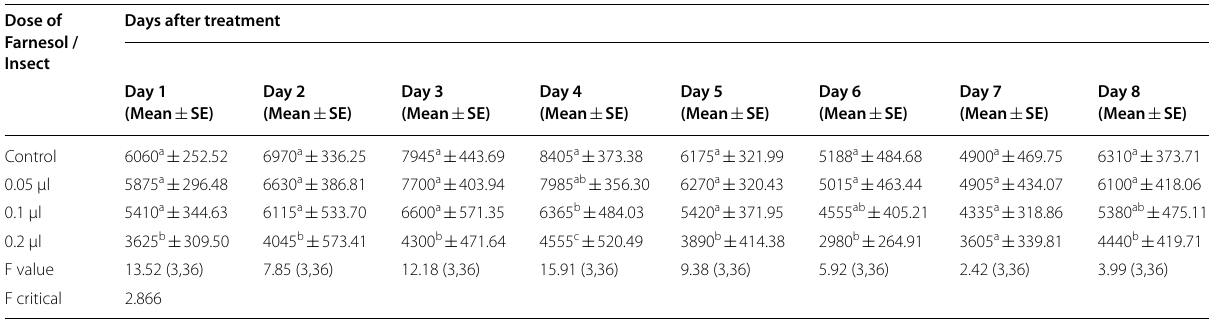
0–6 h old fifth instar nymphs of D. koenigii were treated with 0.05 μl, 0.01 μl, 0.02 μl of Farnesol Mean SE, calculated for ten replicates, Ten fifth instar nymphs were taken in each replicate ± Means followed by the same letter in a column are not statistically different at P < 0.05 (one way ANOVA followed by Tukey test